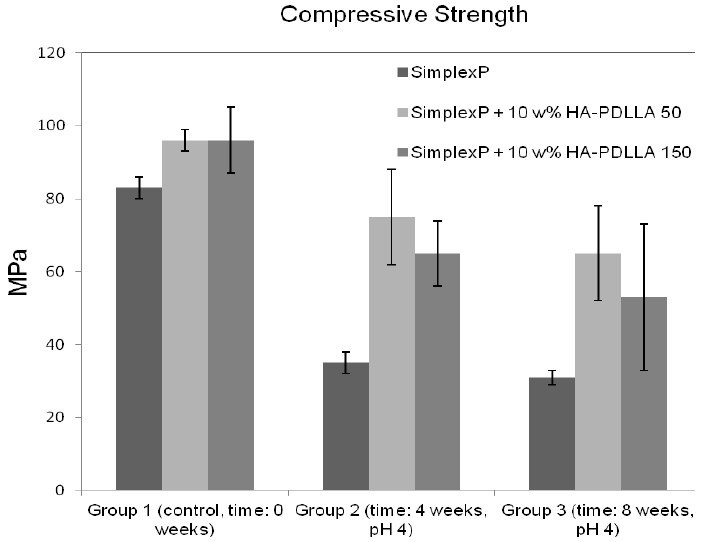
Figure 15. Mean (± SD) compressive strength of standard (Simplex P) and modified bone cement formulations tested before (control) and after accelerated degradation in an acidic solution (pH = 4) for 4 and 8 weeks.